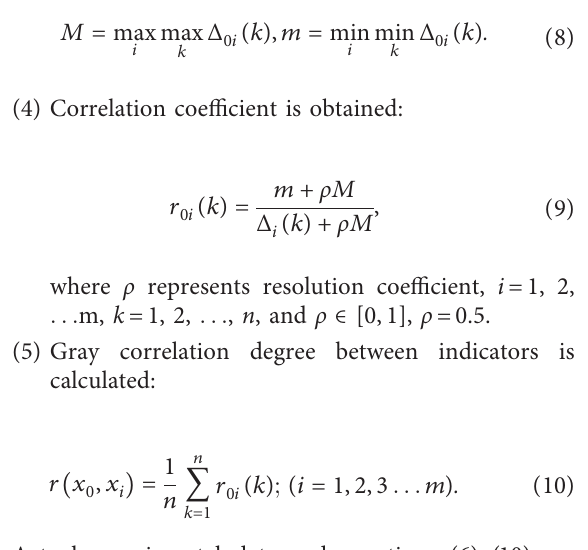
Figure 9: A4B1C3D4E1 combined simulation results with (a) warpage and (b) volume shrinkage. Table 8: Range analysis of volume shrinkage (%).